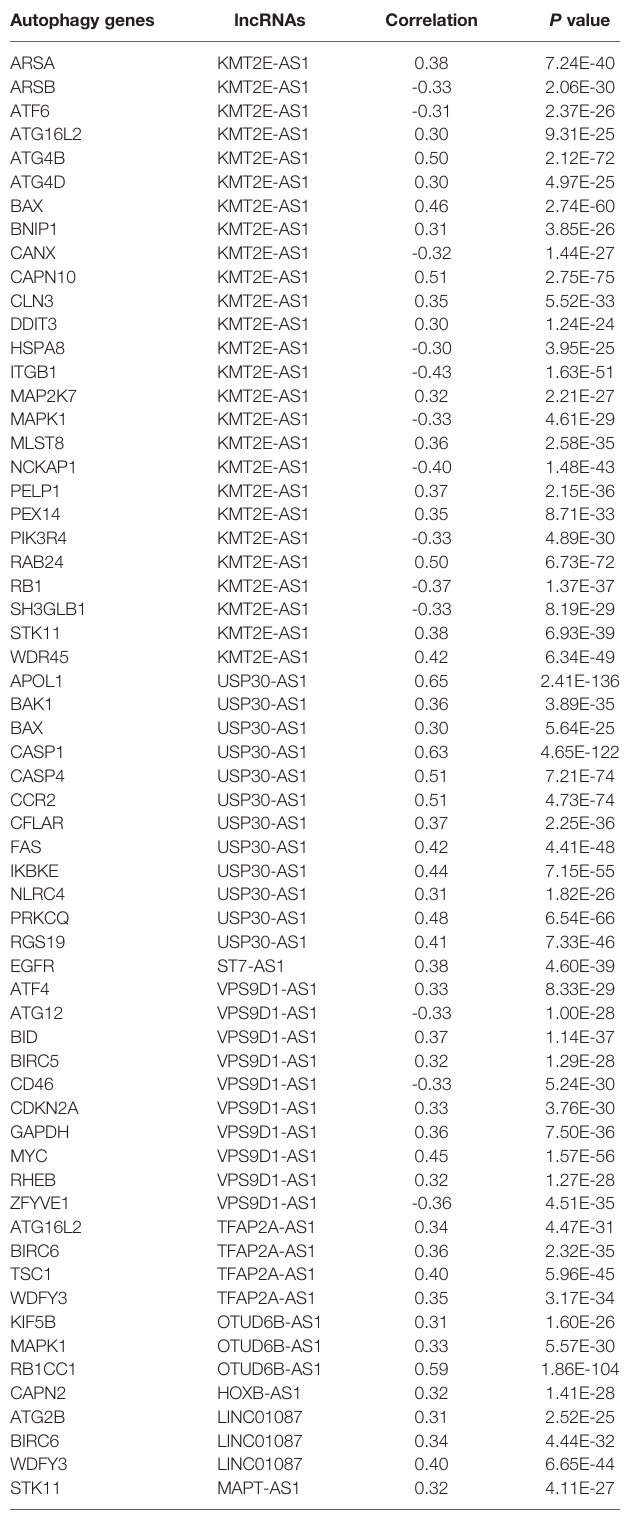
TABLE 2 | Correlation between autophagy genes and lncRNAs in breast cancer. Autophagy genes lncRNAs